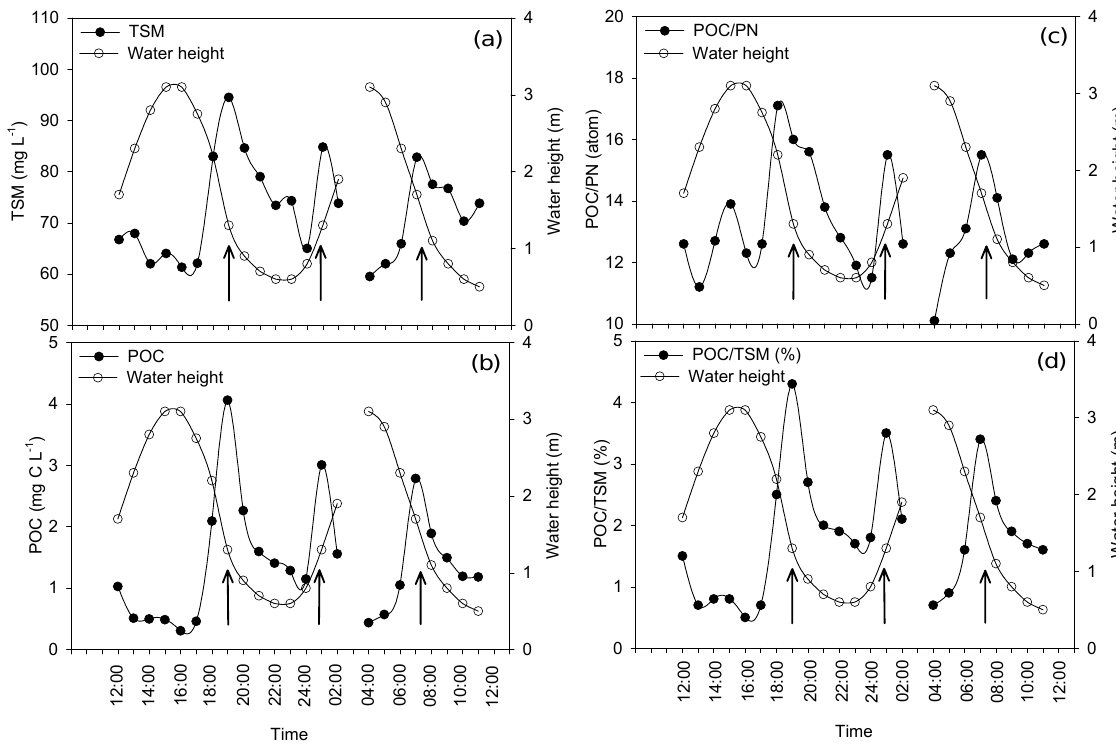
Figure 3 Fig. 3. Tidal variations of water height and (a) TSM, (b) POC, (c) POC/PN ratios (atom) of suspended matter, and (d) the % contribution of POC to the TSM pool. Arrows indicate distinct maxima coinciding with highest tidal